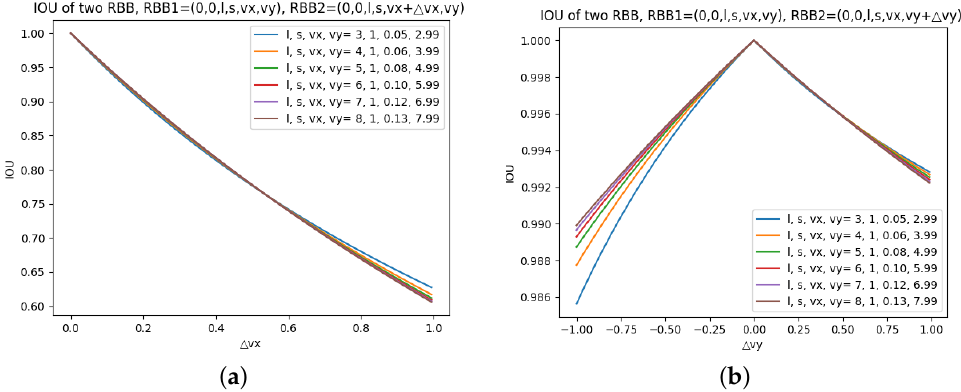
Figure 5. Relationship curves between the prediction deviation of v x , v y and the IOU: ( a ) IOU vs. prediction error of v x ; ( b ) IOU vs. prediction error of v y